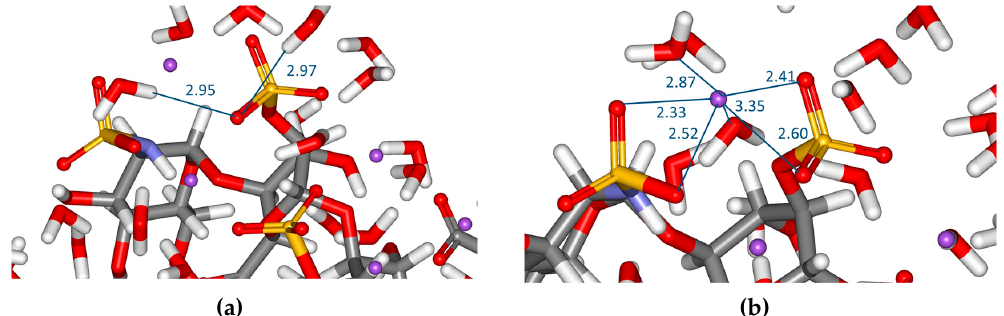
Figure 4. Hydrogen bonds and sodium ion coordination in heparin tetrasaccharide 1 . The computed separations between the pendant groups and water molecules from the first hydration shell X–O···H–O–H are ~2.7–3.1 Å ( a ). Interatomic distances (in Å) refer to oxygen atoms and sodium ions. Oxygen atoms (red) involved in coordination with sodium ion (violet) are displayed as spheres ( b ).